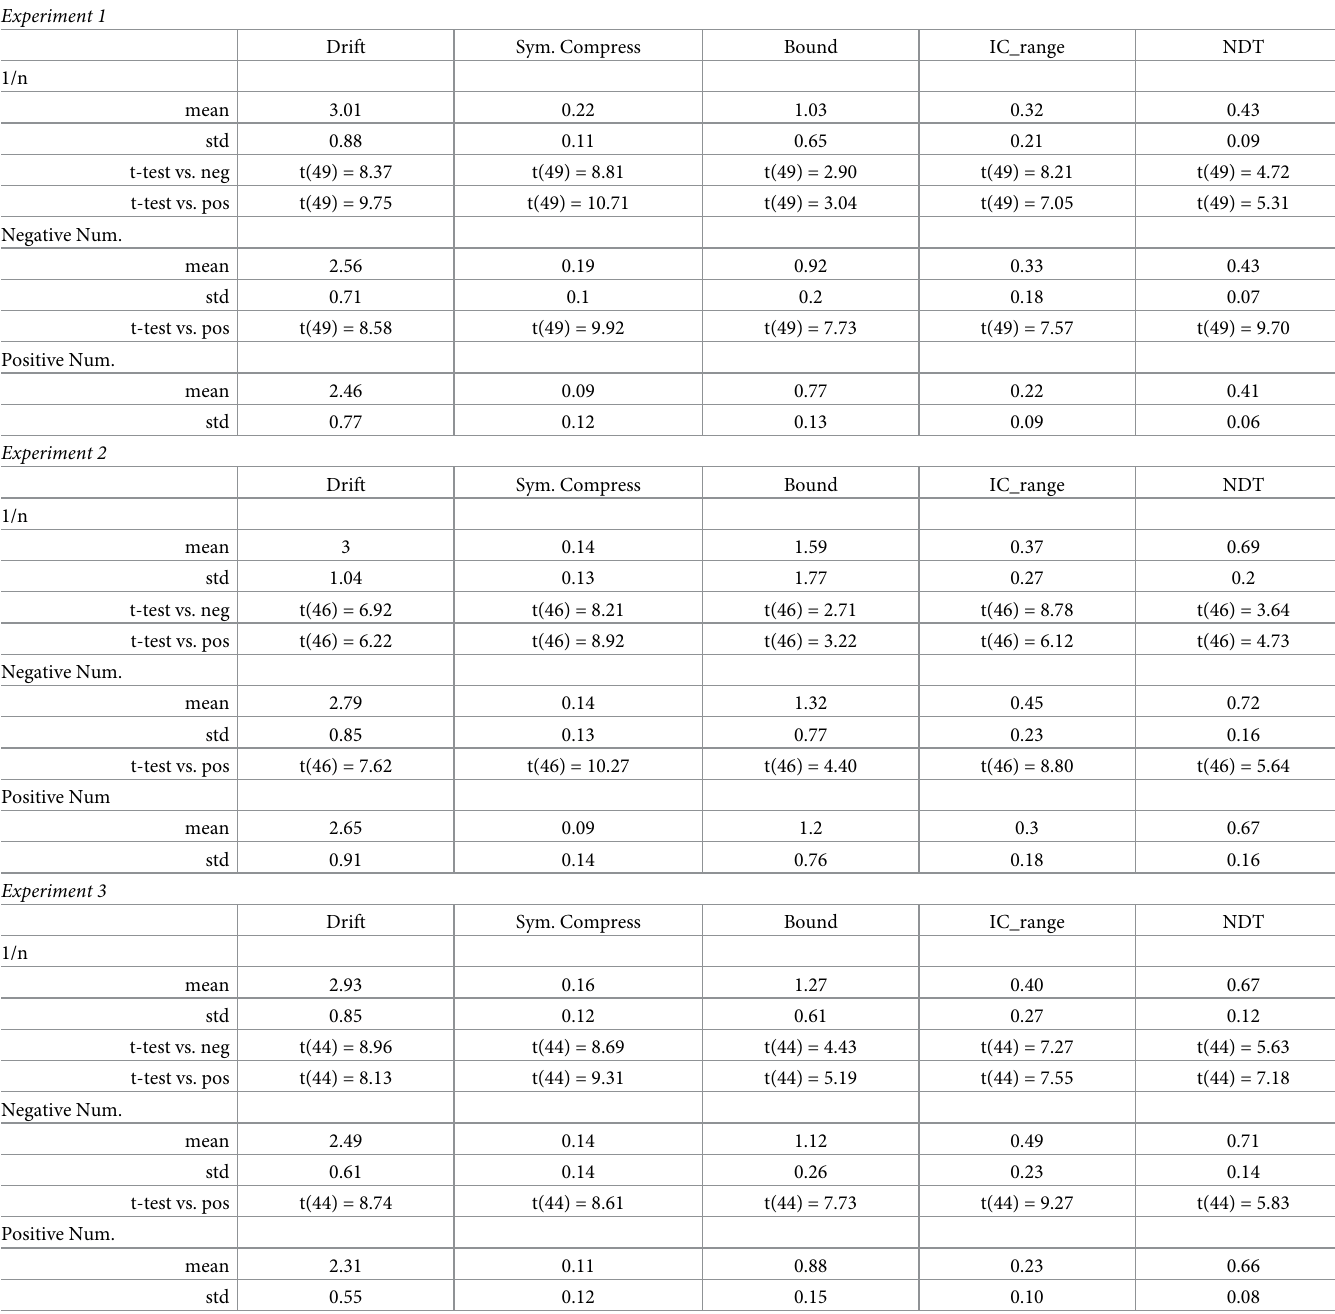
Table 1.3. Avg. parameters of individual fits and one-sample t-tests (vs zero change). Experiment